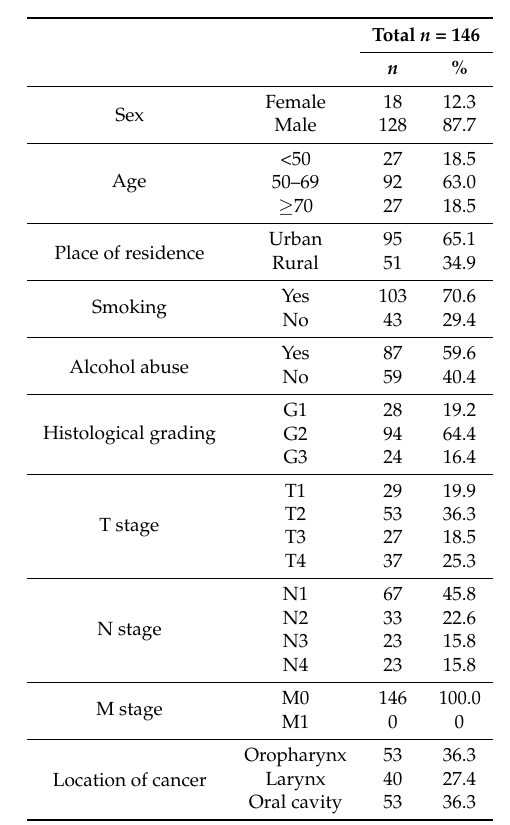
Table 1. Epidemiological and clinical characteristics of patients.